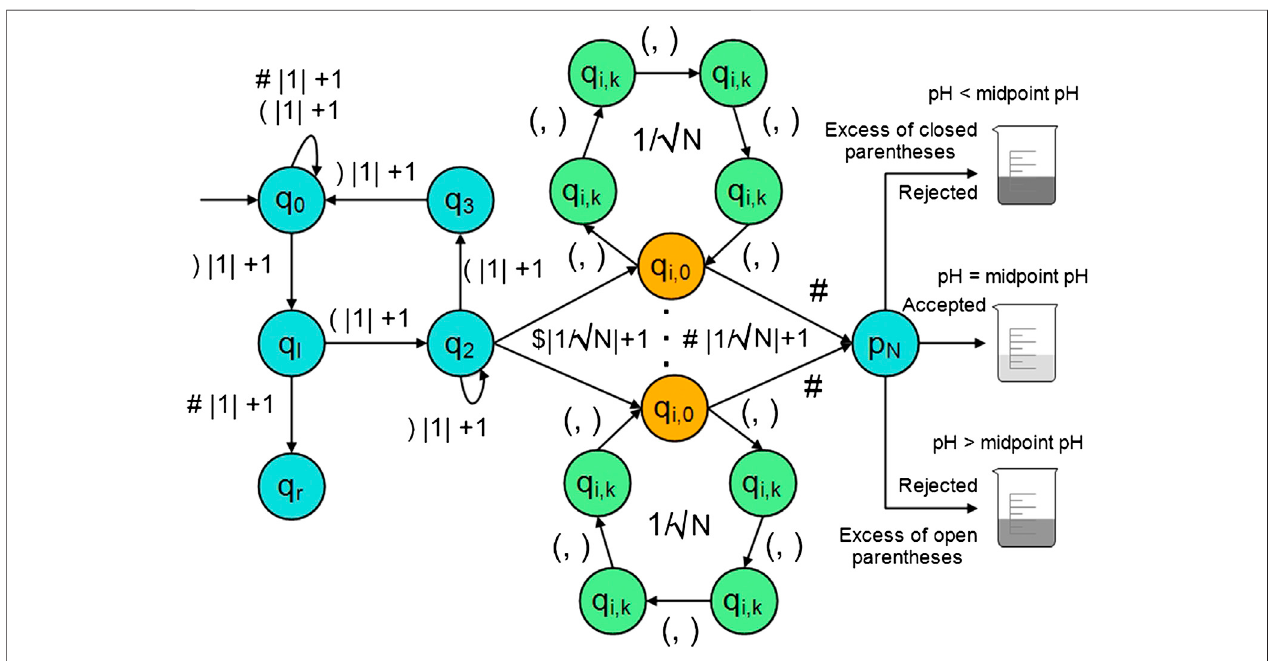
FIGURE 6 | State transition diagram of L 2 .